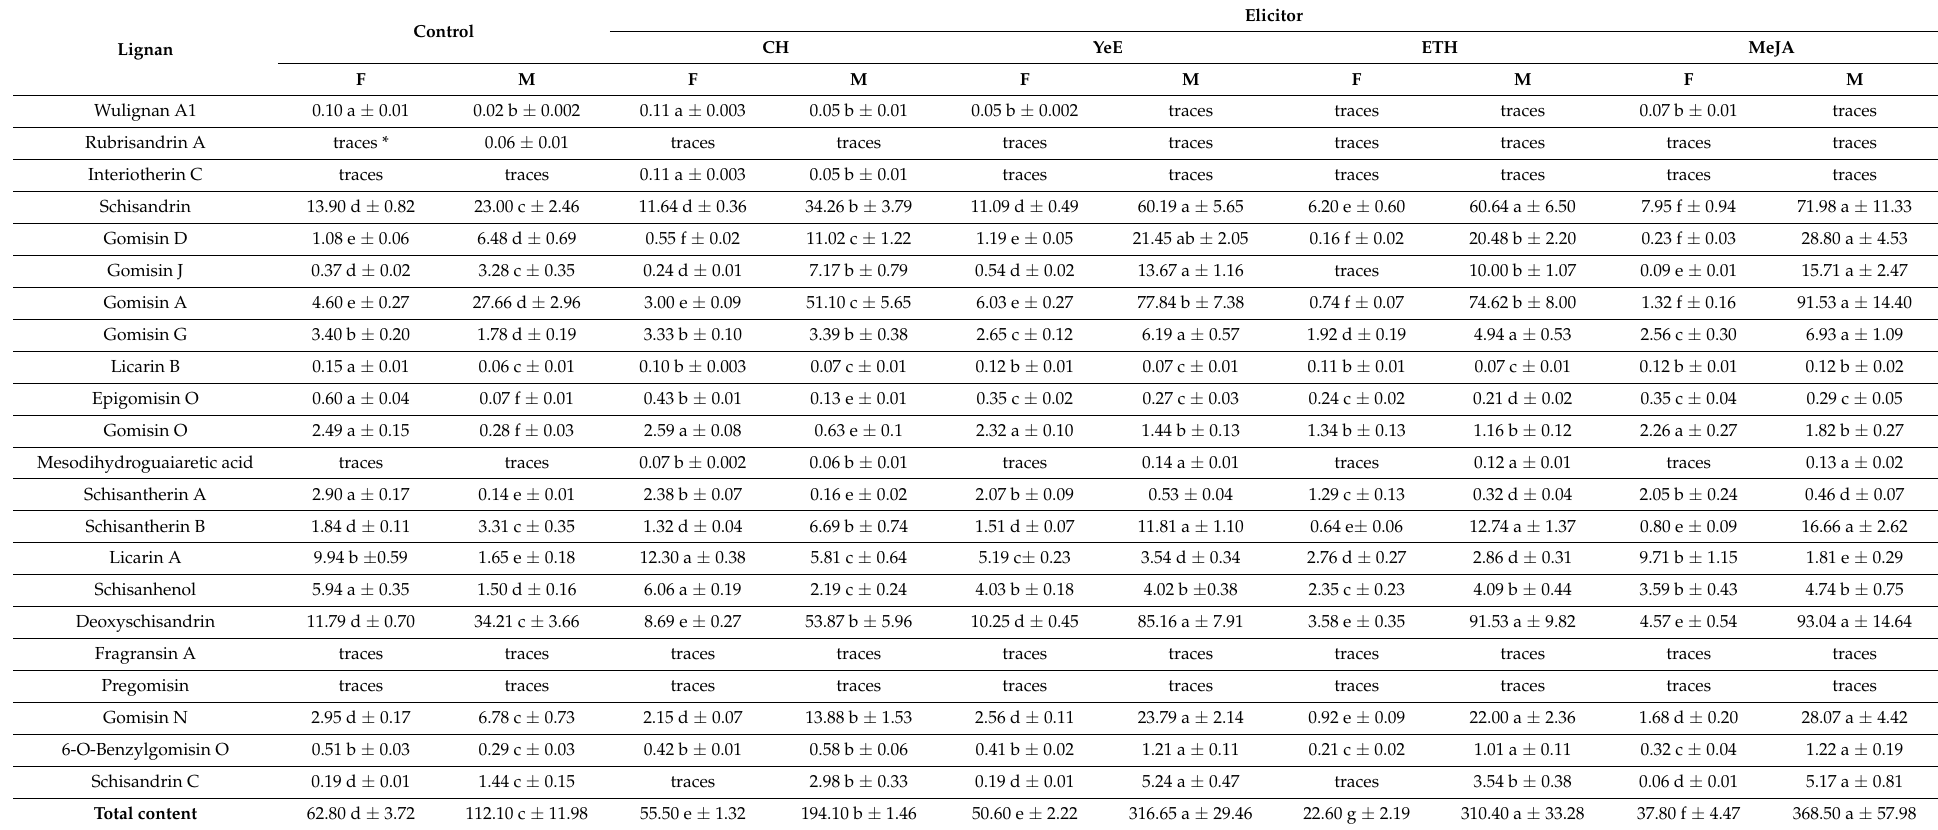
Table 2. Accumulation of lignans (mg/100 g DW) in agitated cultures of S. rubriflora lines F and M 24 h after addition of elicitor. Data expressed as the